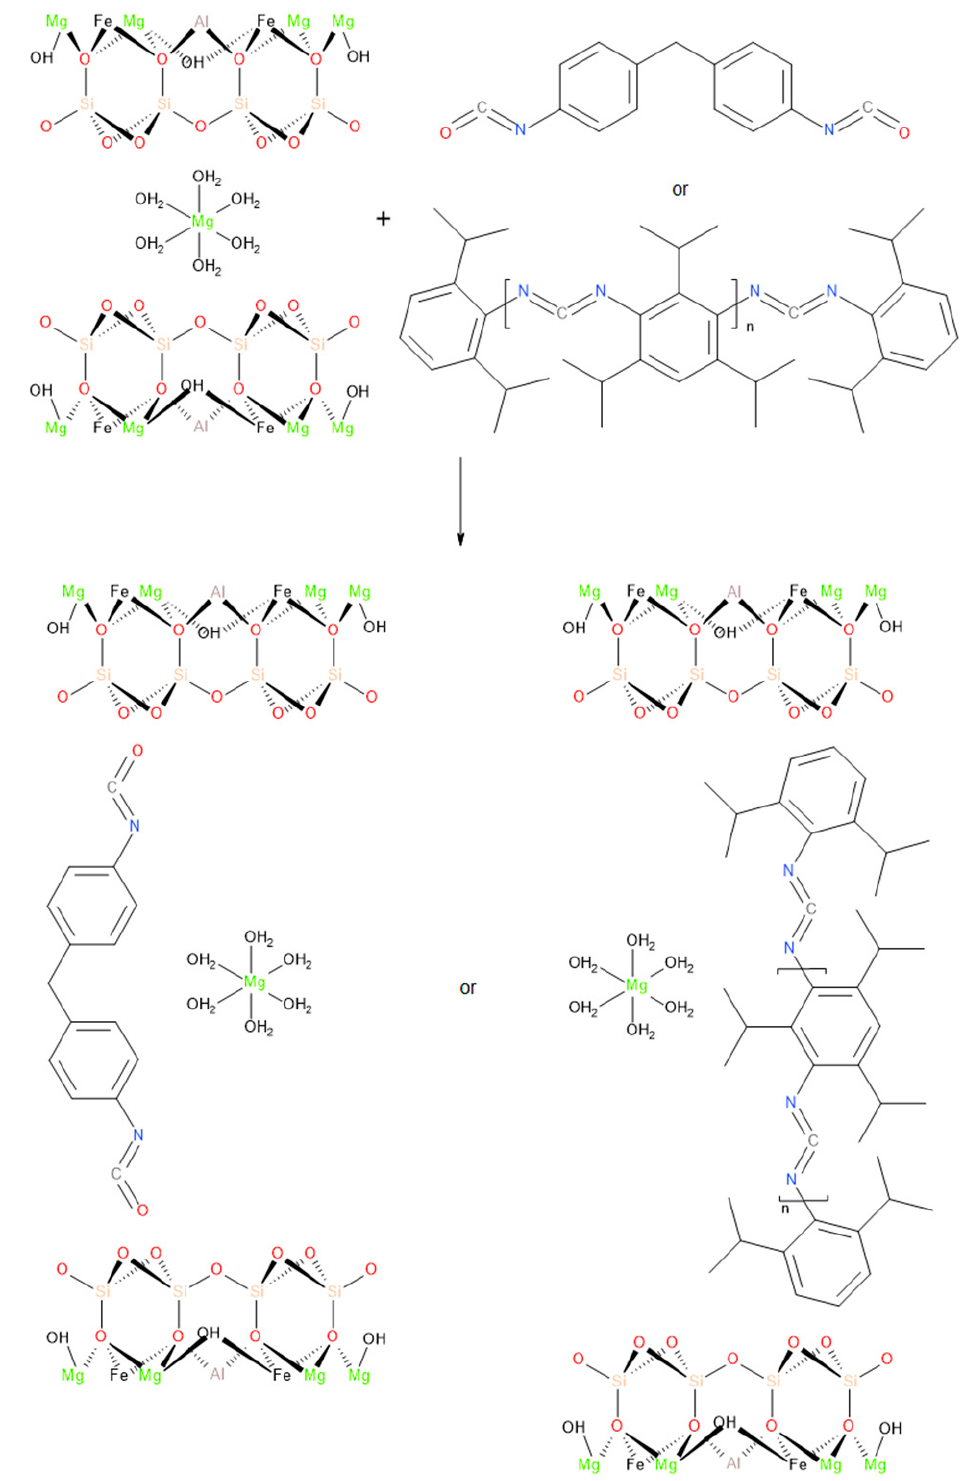
Figure 3. Proposed scheme of interactions between vermiculite and CE.